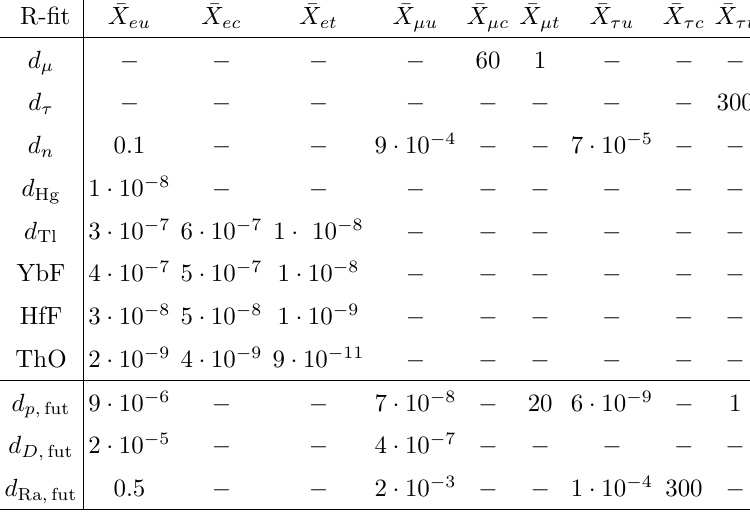
X lq from di(cid:11)erent EDM measurements. We LQ